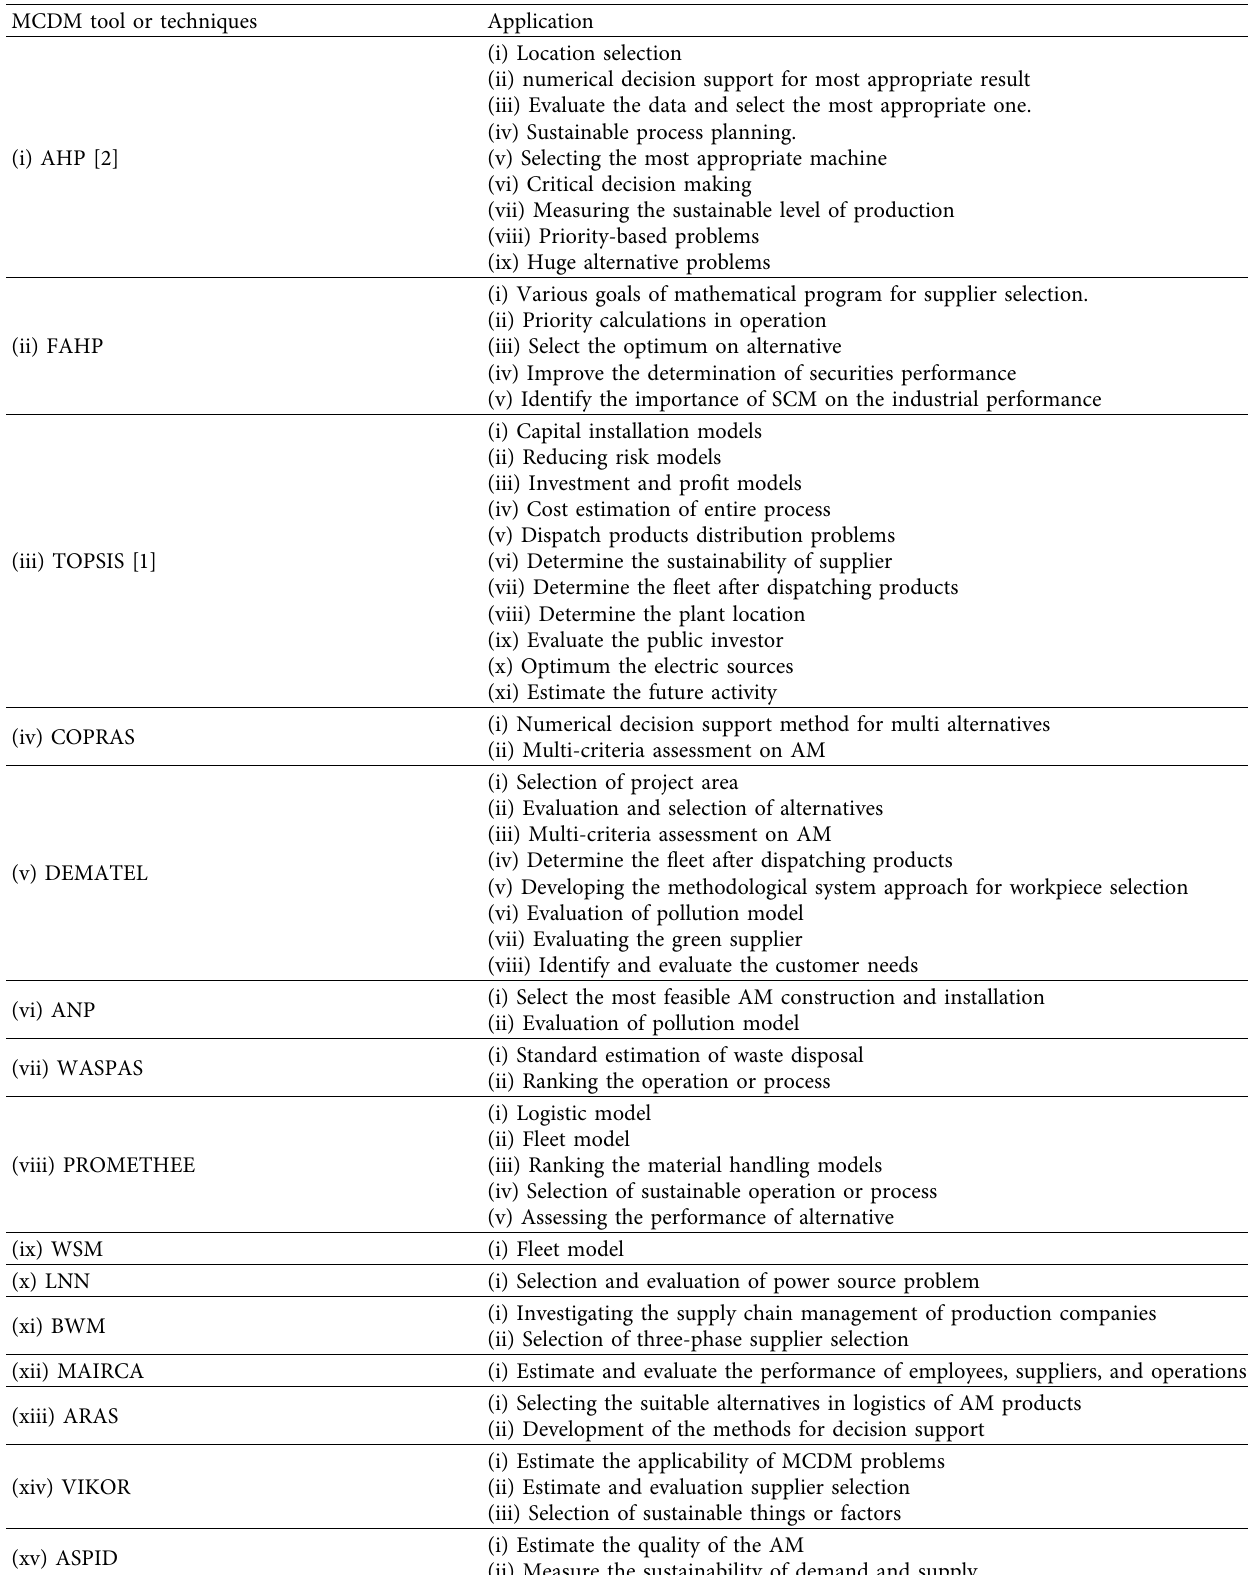
Table 3: MCDM tools/techniques and its application [1, 2,